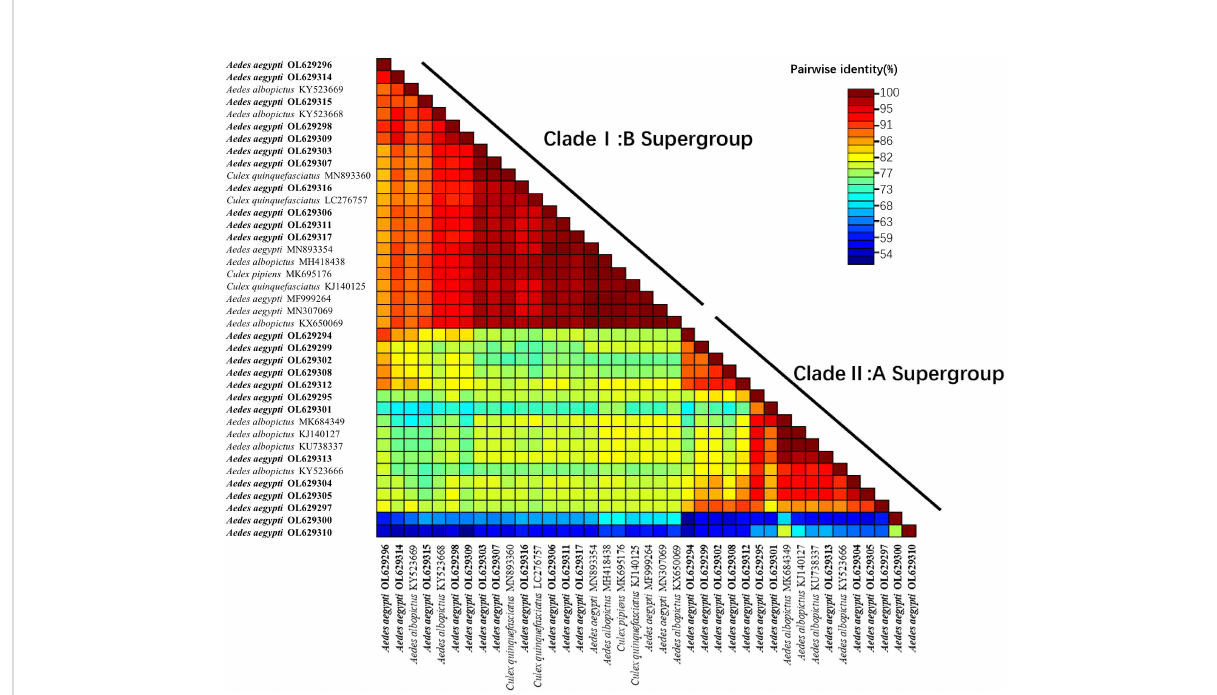
FIGURE 5 Heat map of sequence similarity between sequences obtained using the wsp gene (universal primers: w81F, w691R) and Wolbachia sequences of different mosquito species. The heat map contains 39 nucleotide sequences (24 from this study; 15 from GenBank search), the 15 sequences from GenBank include: 3 from Ae. aegypti , 8 from Aedes albopictus , 3 from Cx.pipiens quinquefasciatus and 1 from Cx pipiens . The number of reference sequences for these four mosquitoes was chosen based on random selection of sequences with higher homology during homology matching on NCBI. Clustal W alignment were performed for each unique pair of sequences, pairwise similarity scores were calculated, and a color-coded matrix of these scores is displayed. The wsp sequences in this study all start with Aedes aegypti OL. OL629294 to OL629298 belong to JHGZ, Xishuangbanna prefecture. OL629299 to OL629301 belong to JHDM, Xishuangbanna prefecture. OL629302 and OL629303 belong to JHFZ, Xishuangbanna prefecture. OL629304 and OL629305 belong to JHML, Xishuangbanna prefecture. OL629306 and OL629307 belong to JHML, Xishuangbanna prefecture. OL629308 to OL629310 belong to DLAA, Xishuangbanna prefecture. OL629311 and OL629312 belong to DLXX, Xishuangbanna prefecture. OL629313 belongs to JHJL, Xishuangbanna prefecture. OL629314 to OL629316 belong to JGLS, Dehong prefecture. OL629317 belongs to RLJK, Dehong